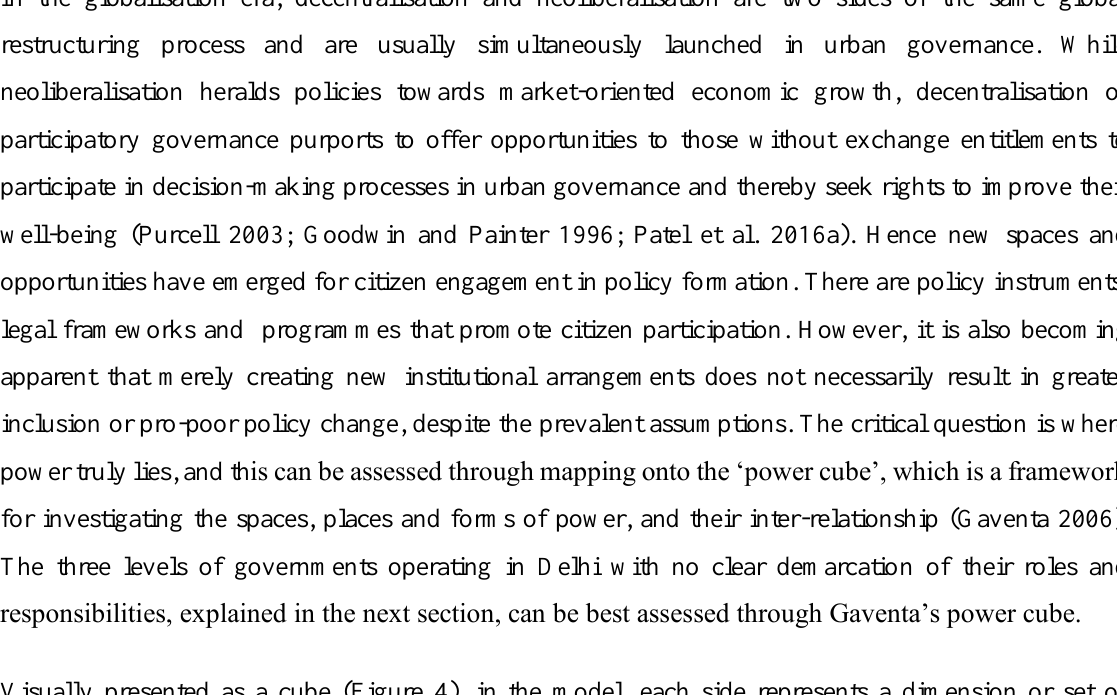
Source: Choguill (1996, p.